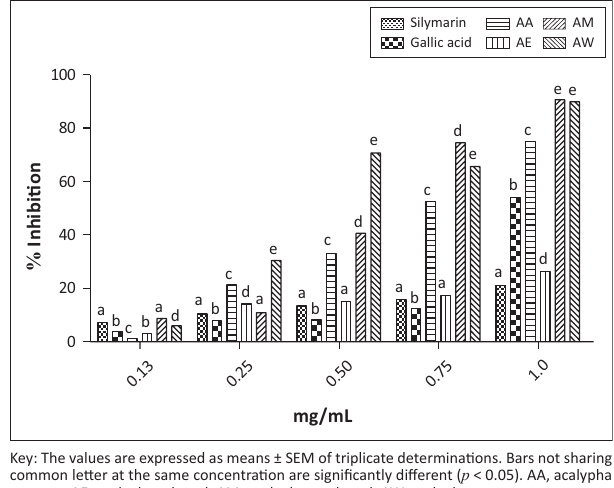
FIGURE 2: Ferric reducing antioxidant power of leaf extracts of Acalypha godseffiana .